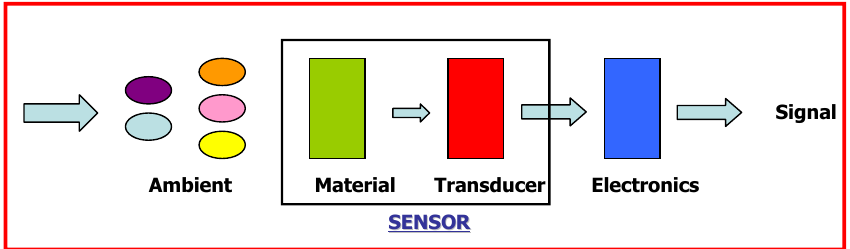
Figure 1. Scheme of a solid-state chemical sensor with gas-sensitive material, transducer and interface electronics.